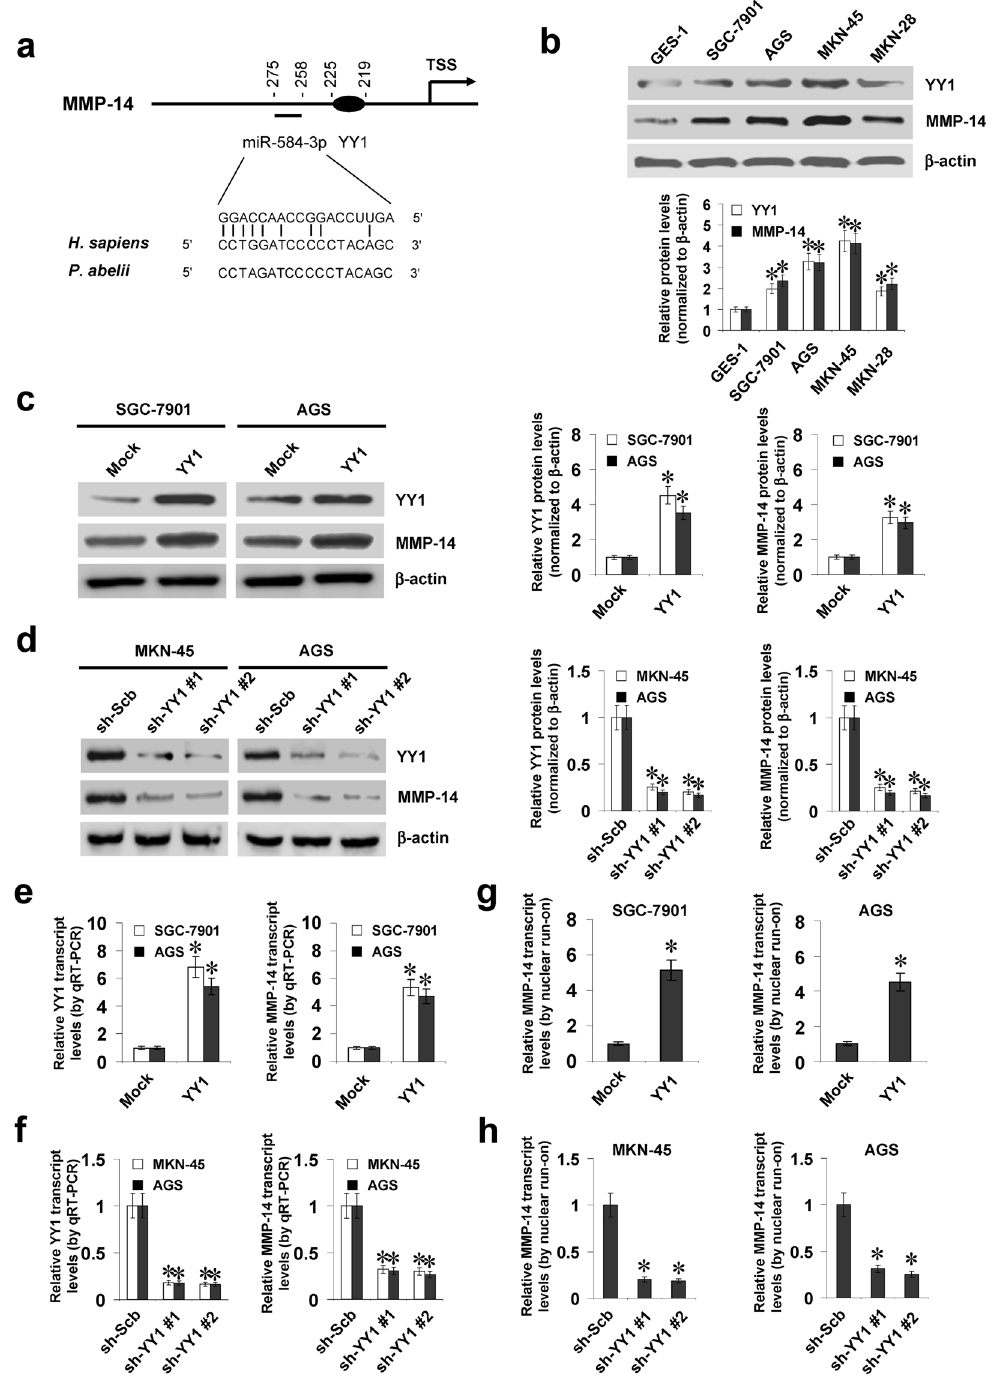
Figure 1. YY1 facilitates the expression of MMP-14 in gastric cancer cells. ( a ) Scheme of potential binding sites of YY1 and miR-584-3p within the MMP-14 promoter, locating at bases − 225/ − 219 and − 167/ − 150 relative to TSS. ( b ) Western blot showing the expression of YY1 and MMP-14 in normal gastric epithelial GES-1 cells and gastric cancer cell lines SGC-7901, AGS, MKN-45, and MKN-28. ( c and d ) Western blot indicating the expression of YY1 and MMP-14 in SGC-7901, AGS and MKN-45 cells stably transfected with empty vector (mock), YY1 , scramble shRNA (sh-Scb) or two YY1 shRNAs (sh-YY1 #1 and sh-YY1 #2). ( e and f ) Real-time quantitative RT-PCR showing the transcript levels of YY1 and MMP-14 in gastric cancer cells stably transfected with mock, YY1 , sh-Scb or sh-YY1 (mean ± SD, n = 5). ( g and h ) Nuclear run-on assay indicating the nascent MMP-14 transcript levels in gastric cancer cells stably transfected with mock, YY1 , sh-Scb, or sh-YY1 (mean ± SD, n = 4). * P < 0.01 vs. GES-1, mock, or